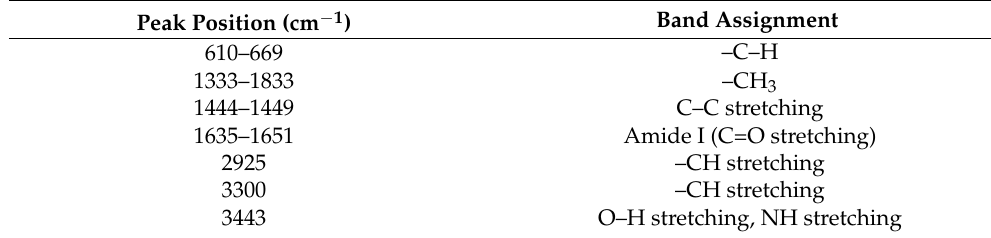
Table 2. ATR-FTIR band assignments of gelatin that were affected by atmospheric-air plasma treat- ment.